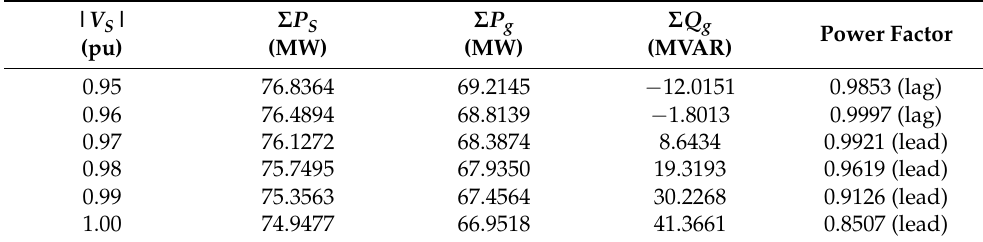
Table 8. Stator power, WPP output and power factor ( V w = 8 m/s).